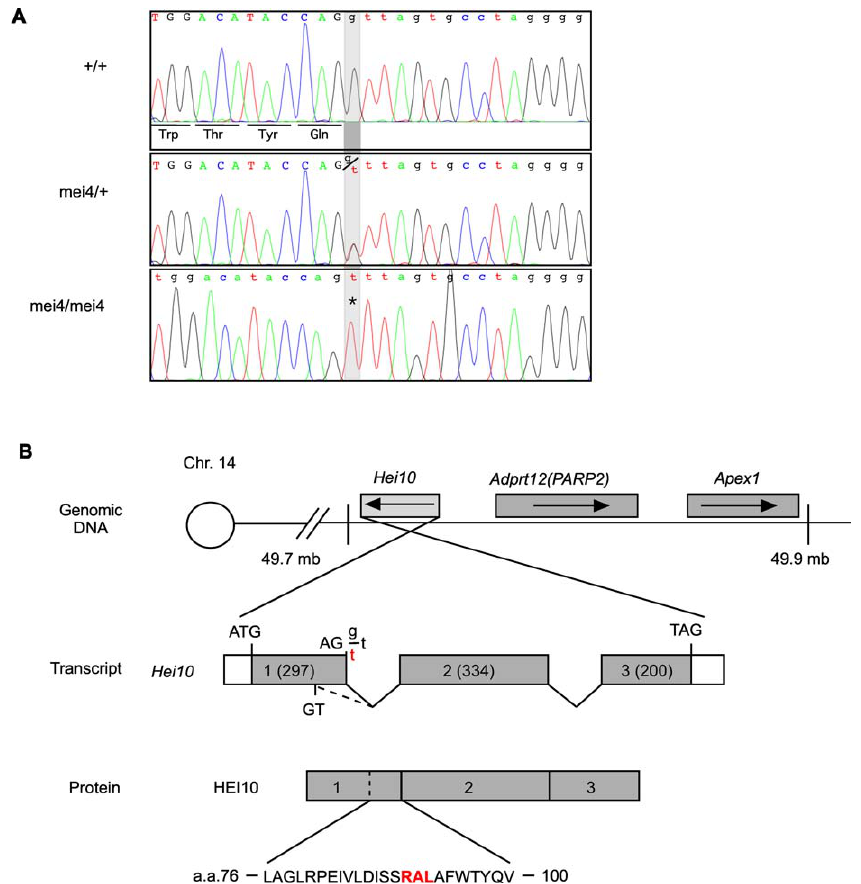
Figure 5. Genomic Sequencing of Hei10 Reveals a Mutation in the Consensus GT 5 9 Splice Site in Intron 1 (A) Genomic DNA from þ / þ , mei4/ þ , and mei4/mei4 animals was sequenced, and a single base transversion (g . t, gray shading) was found in the 5 9 splice site consensus GT sequence. Exon sequence is denoted with capital letters and intron sequence with lower case. (B) The 5 9 splice site of intron 1 contains the consensus GT dinucleotide ( Hei10 ). The splice site mutation described in (A) (g . t, red t indicates mutant form) causes the splicing machinery to select a GT site 72 bp upstream of the original site (dashed line). The 72-bp in-frame section of exon 1 is removed with intron 1 and is not present in the mature transcript (sequence not shown). The predicted protein sequence of HEI10 in mei4/mei4 animals contains a deletion of amino acids (a.a.) 76–100 including a conserved putative cyclin binding domain (red